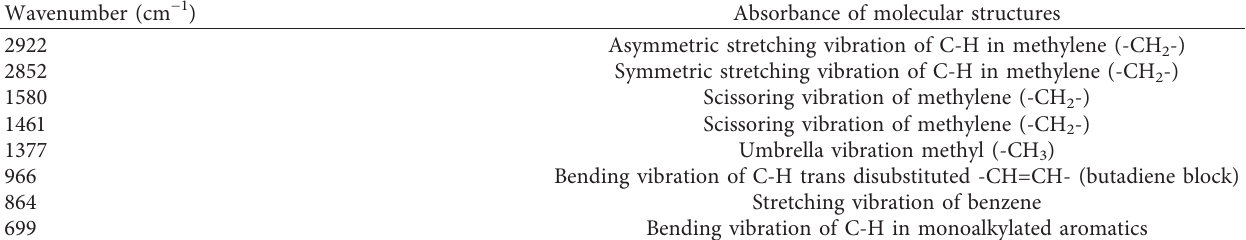
Table 3: Characteristics of molecular structures at different wavenumbers [28–30].